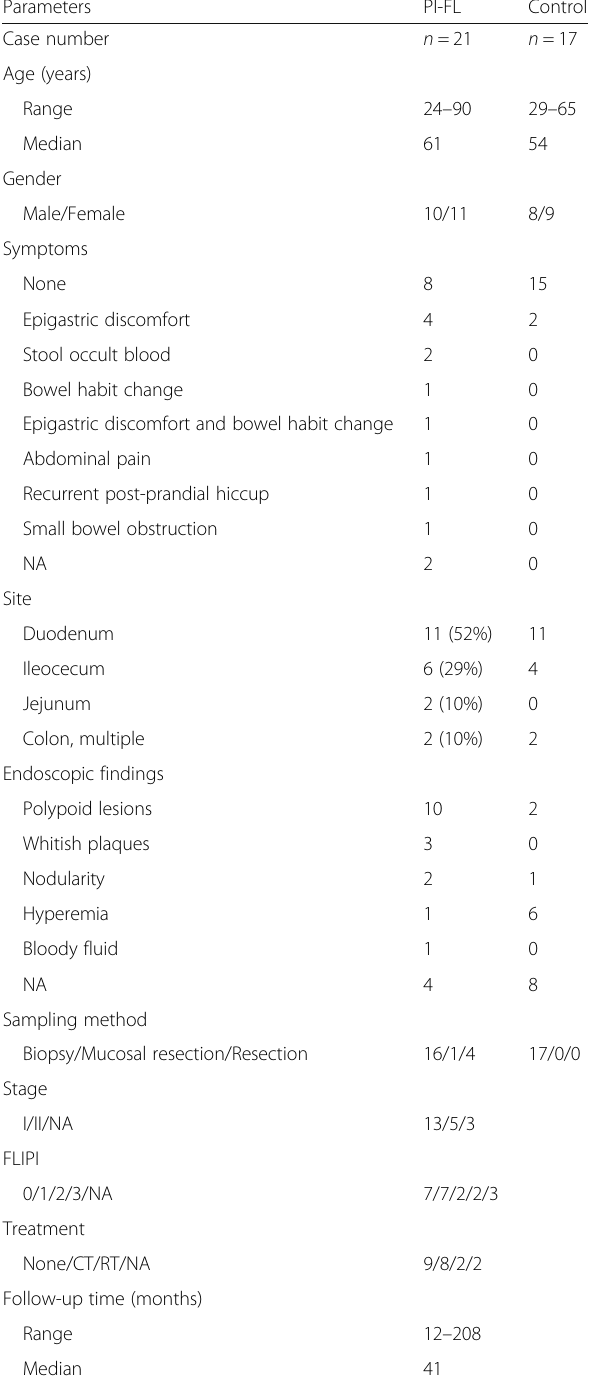
Table 1 Pertinent clinical information of the patients with PI-FL and the control cases with reactive lymphoid